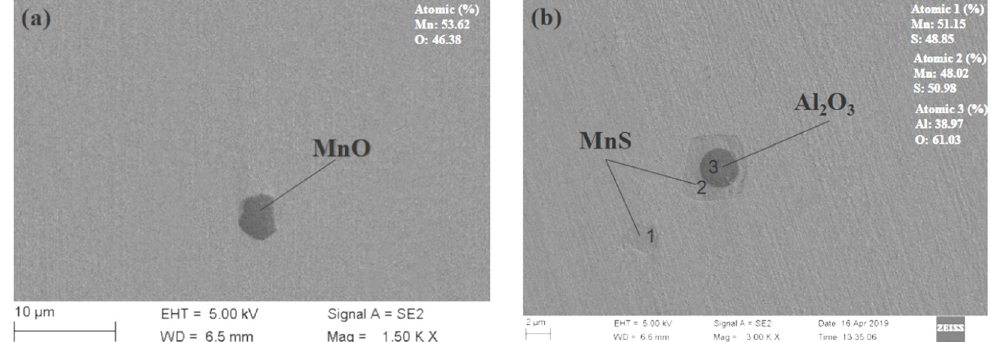
Figure 2. Morphology of typical inclusions in TWIP steel (steel A) (the preset Al content is 0, and the actual Al content is 0.014%). ( a ) MnO inclusion; ( b ) Al 2 O 3 -MnS complex inclusion.